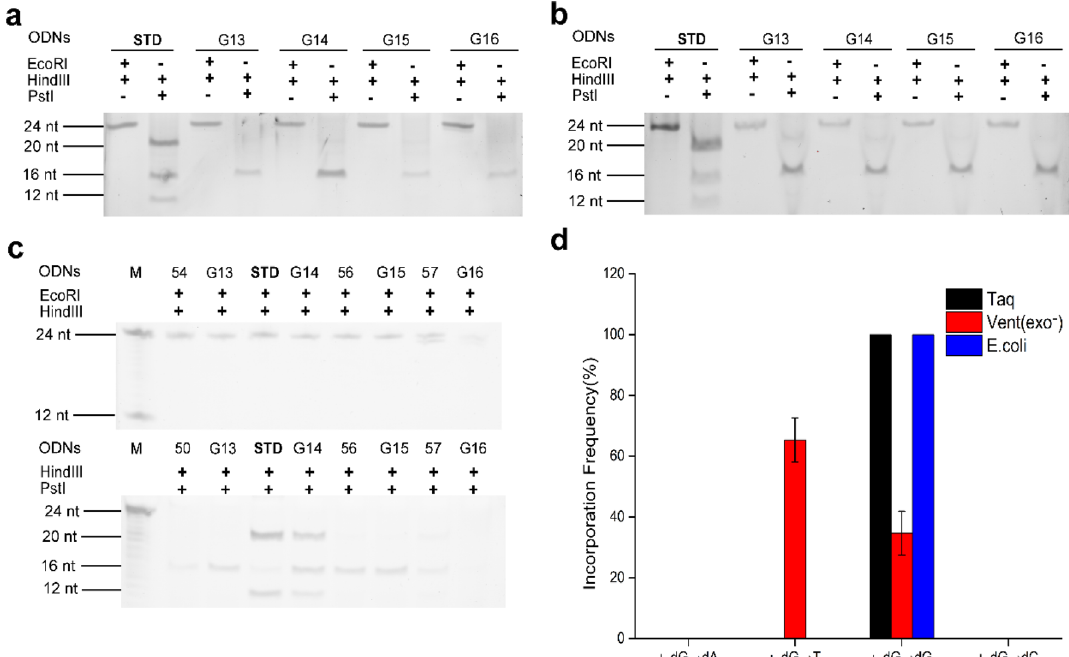
Figure 3. PAGE analysis of restriction fragments of replication products arising from the l-dG lesion-bearing genome ( a ) Taq DNA polymerase ( b ) Vent (exo - ) DNA polymerase ( c ) E. coli cells and ( d ) its mutation